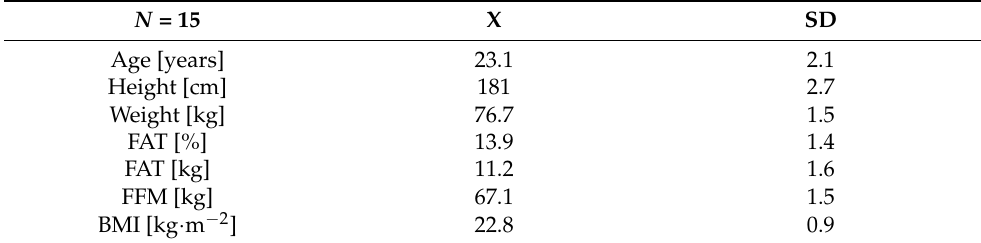
Table 1. Anthropometric characteristics of the